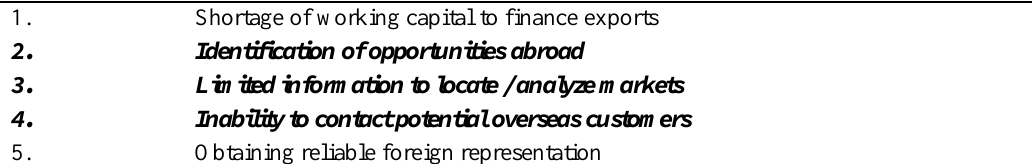
Table 1 : The top five barriers to exporting (OECD,